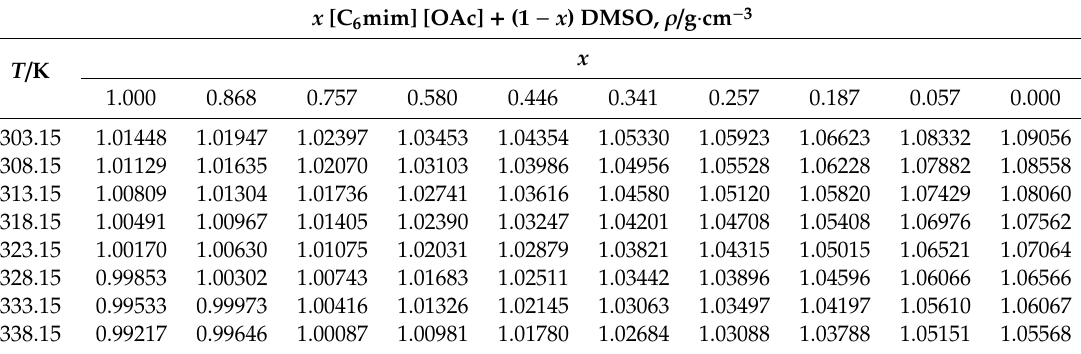
Table 5. Experimental densities of [C 6 mim] [OAc] with dimethyl sulfoxide (DMSO)at (0.0967 ± 0.002) MPa from 303.15 to 338.15 K and x is IL mole